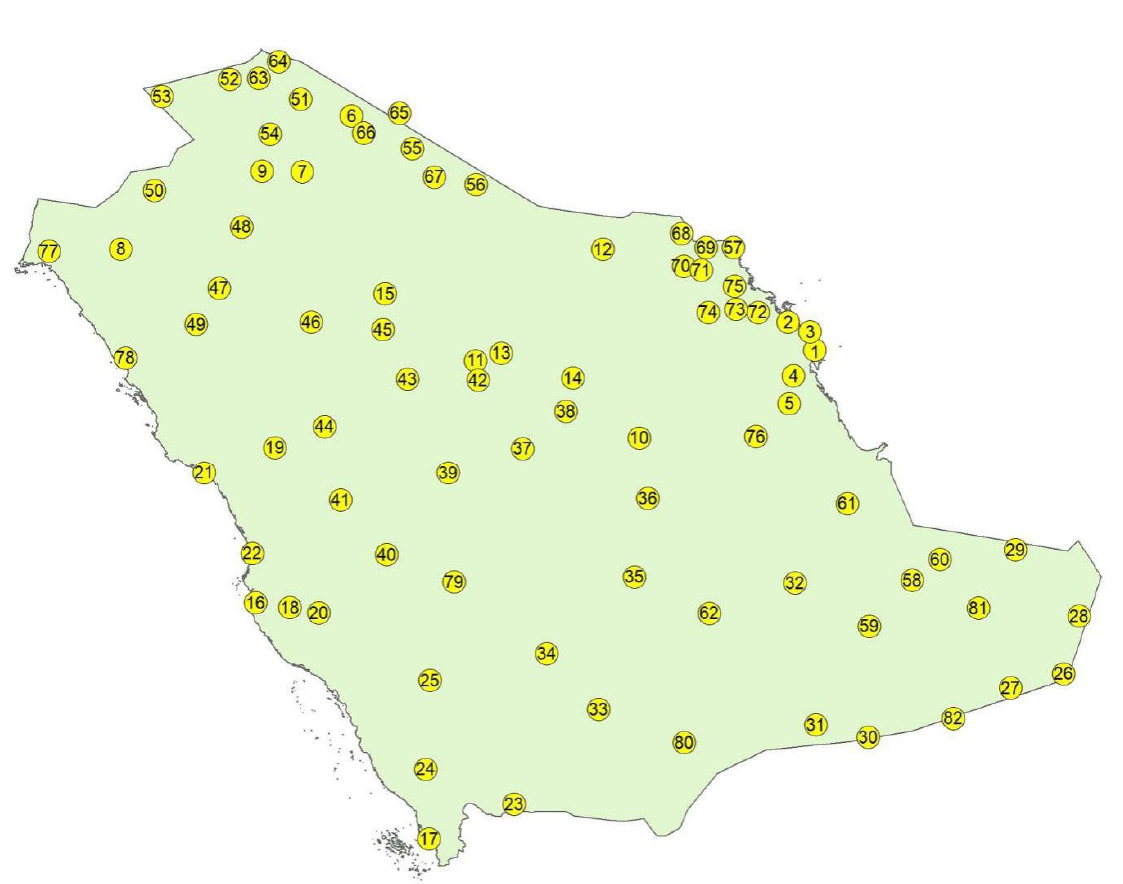
Figure 1. Distribution of the 82 sites in Saudi Arabia. The numbers in the circles refer to those in column 1 of Table 1 reported in [30]. This figure is a reproduction of Figure 1 in [30].